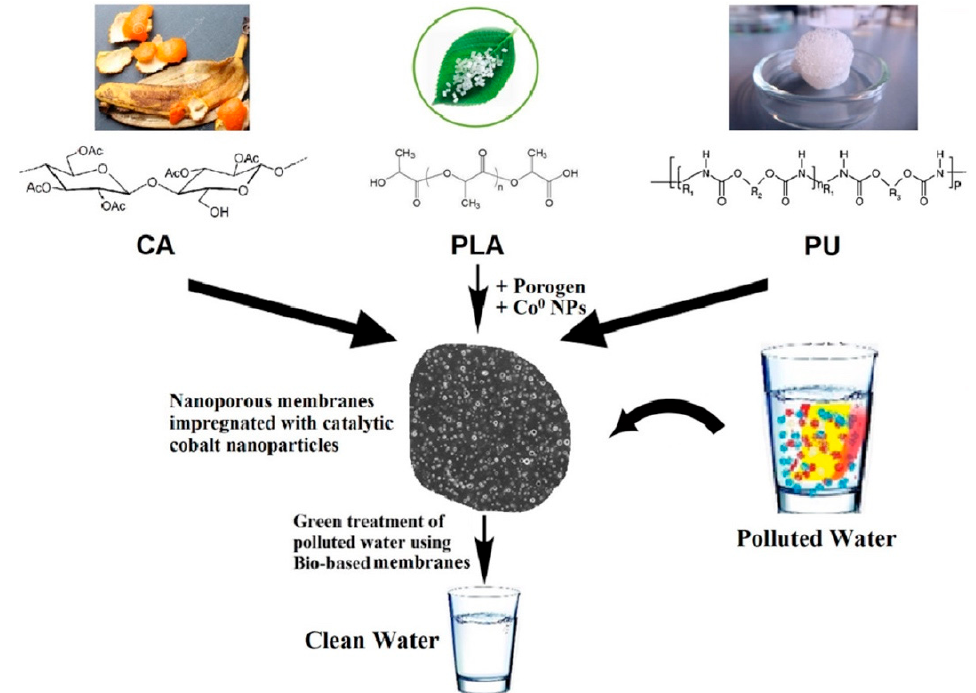
Figure 3. Nanoporous membranes synthesized from bio-based polymeric blends and impregnated with CoNPs for the treatment of polluted water [120].